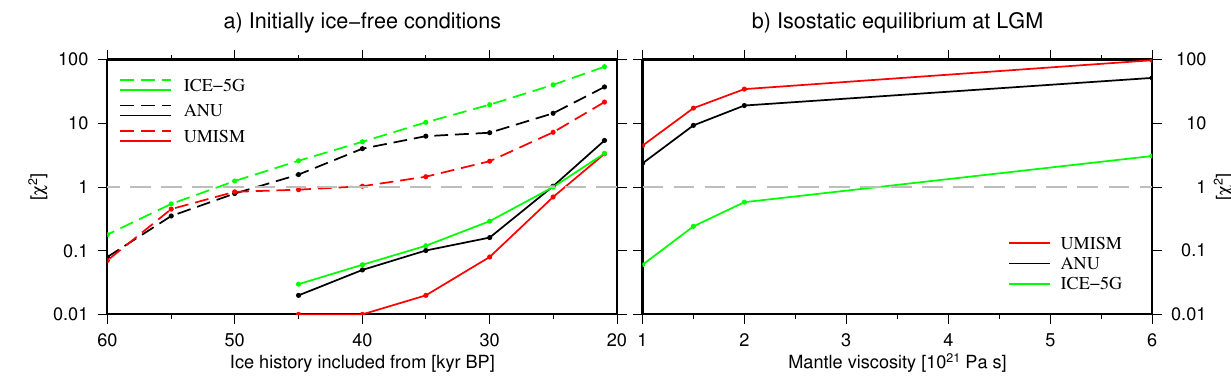
Figure 6. Fit of uplift rates predicted by perturbed ice sheets models to uplift rates predicted by unperturbed models. (a) Models assuming ice-free conditions up until 1kyr prior to the time indicated by the time axis in the figure, followed by a 1kyr linear increase to the ice thicknesses in the ICE-5G (green), ANU (black) or UMISM (red) reconstructions. Dashed lines display results for models with a mantle viscosity of 6 × 10 21 Pas, and solid lines for models with a mantle viscosity of 10 21 Pas. (b) Models assuming isostatic equilibrium prior to the LGM in ICE-5G (green, 21kyrBP), ANU (black, 21kyrBP) and UMISM (red, 18.2kyrBP). All earth models have a lithospheric thickness of 120km.